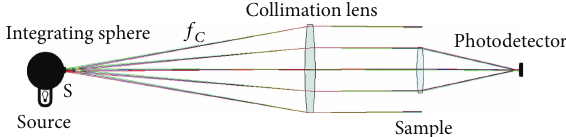
Figure1:Schemeofcollimator S1 (forimagetestsandfocusedimage meas. on small components).